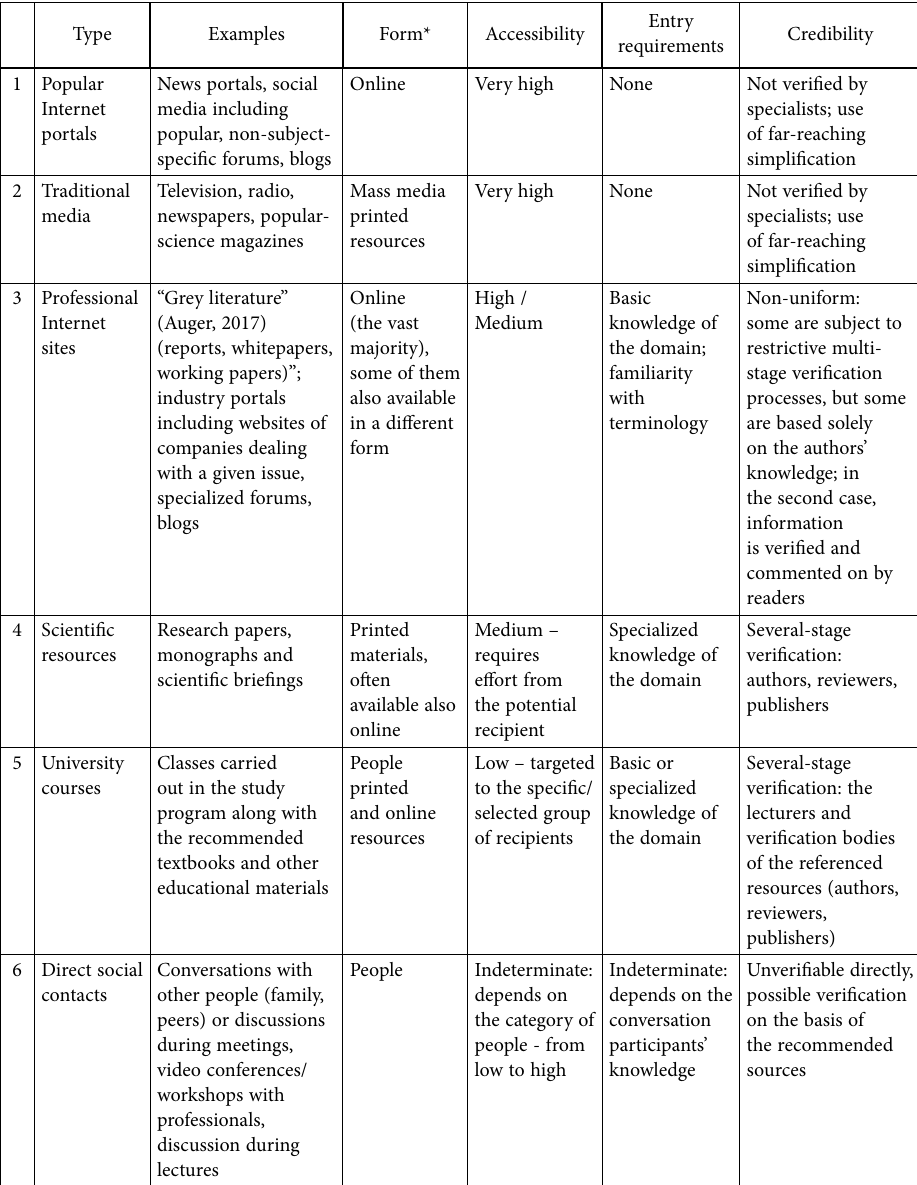
Table 3. Classification of information